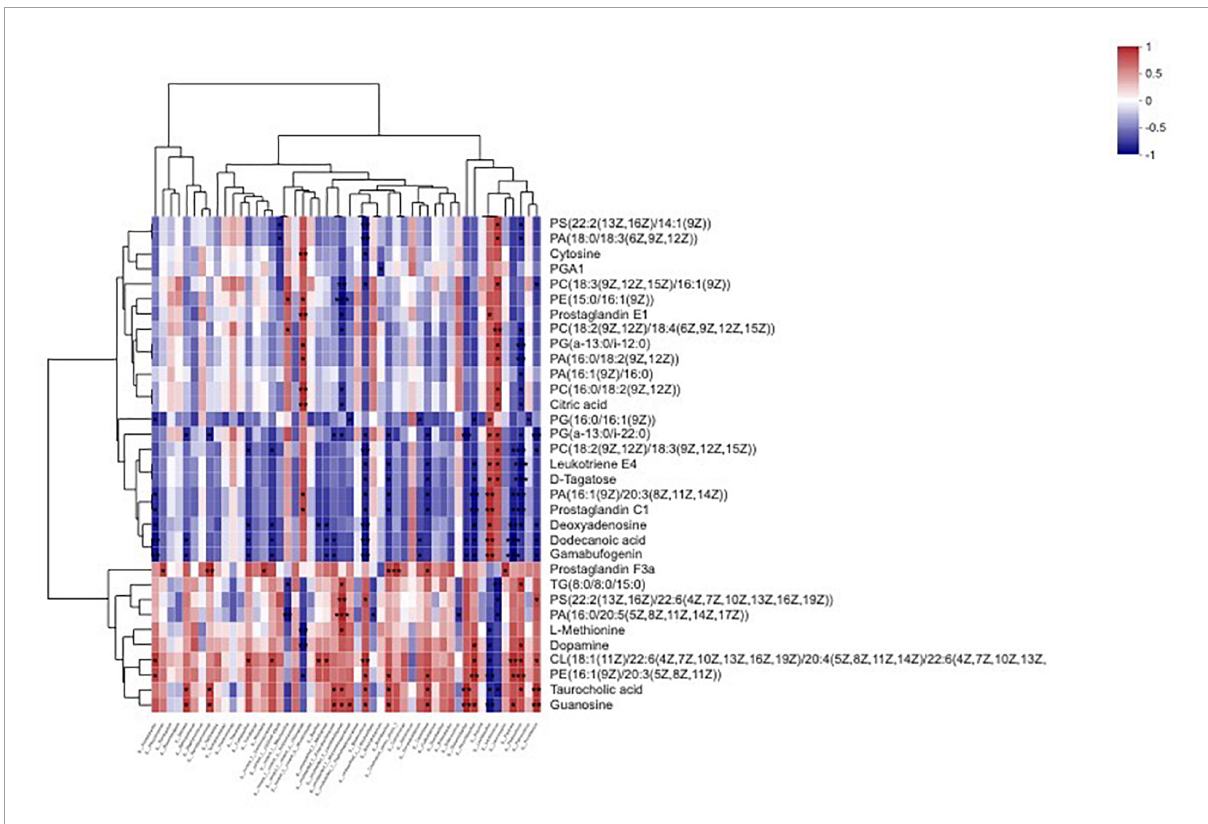
FIGURE8 Heatmap of the correlation analysis for bacteria and metabolites in sainfoin silage. ∗ p < 0.05, ∗∗ 0.01 < p < 0.05, ∗∗∗ p < 0.01.